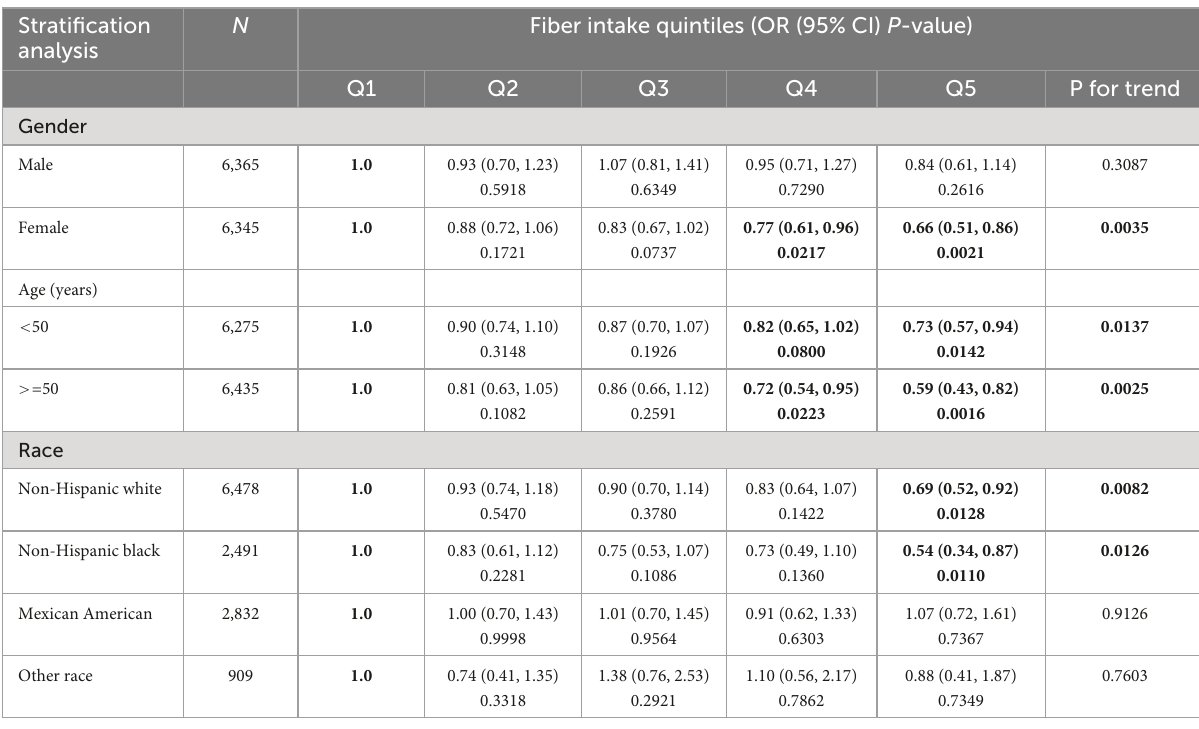
TABLE 3 Association between severe headache or migraine with fiber intake quintiles stratified by gender, age, and race (raw data). Stratification